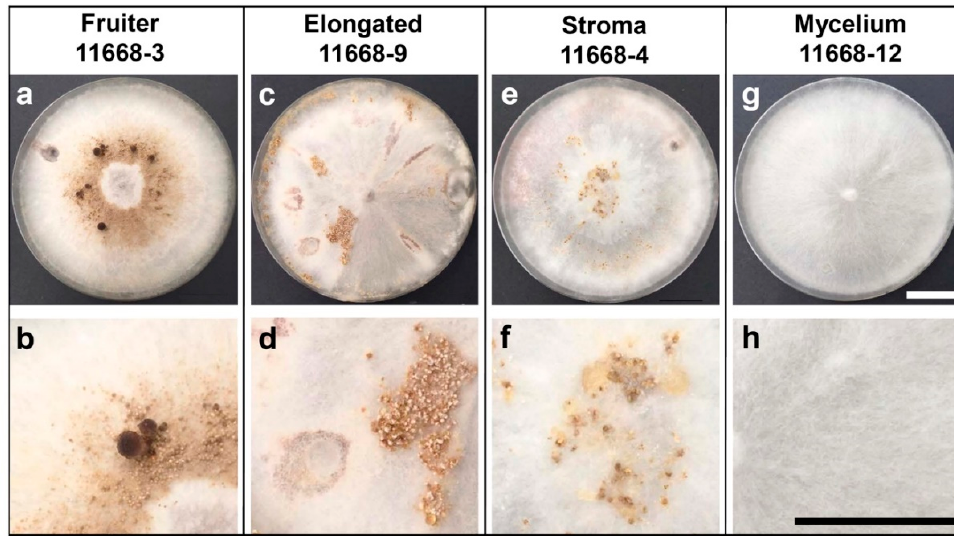
Figure 1. Spectrum of fruiting phenotypes by monokaryotic progeny of C. parasitica ICMP 11668. Strains were reared in the fruiting setup by Herzog et al. [18]: they were grown on 1.5% MEA for 16–19 days at 25 °C in the dark. Fully colonized plates were fruiting-induced at 20 °C in a 12 h light/12 h dark rhythm at saturated humidity in microfilter-aerated wet chambers. The different fruiting phenotypes are displayed by respective monokaryons exhibiting them. The fruiter type strain C. parasitica ICMP 11668-3 displayed monokaryotic basidiomes ( a , b ), strain C. parasitica ICMP 11668-9 exhibited elongated structures ( c , d ), and strain C. parasitica ICMP 11668-4 formed bloated structures ( e , f ) that Esser et al. [24], in a different species, referred to as ‘stromatic structures’ or ‘stromata’. All other strains did not form any fruiting structures, only displaying monokaryotic my- celium. They are represented by C. parasitica ICMP 11668-12 ( g , h ). The scale bar represents 2 cm.